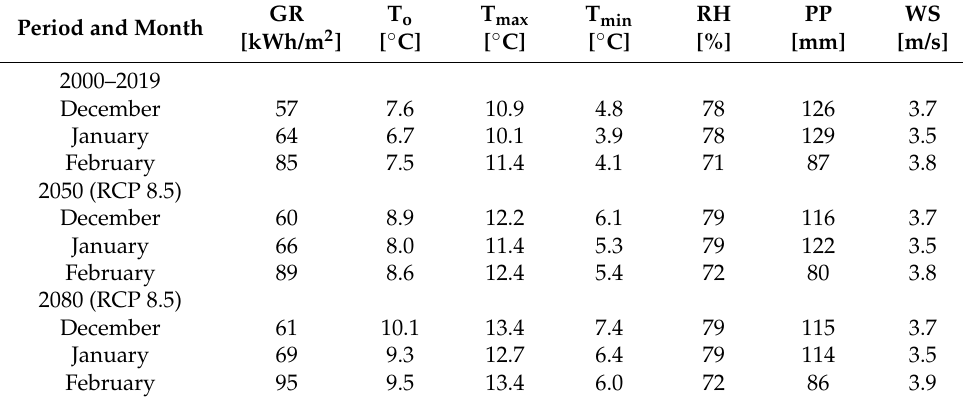
Table 1. Meteorological data for the city of Covilh ã . Period and